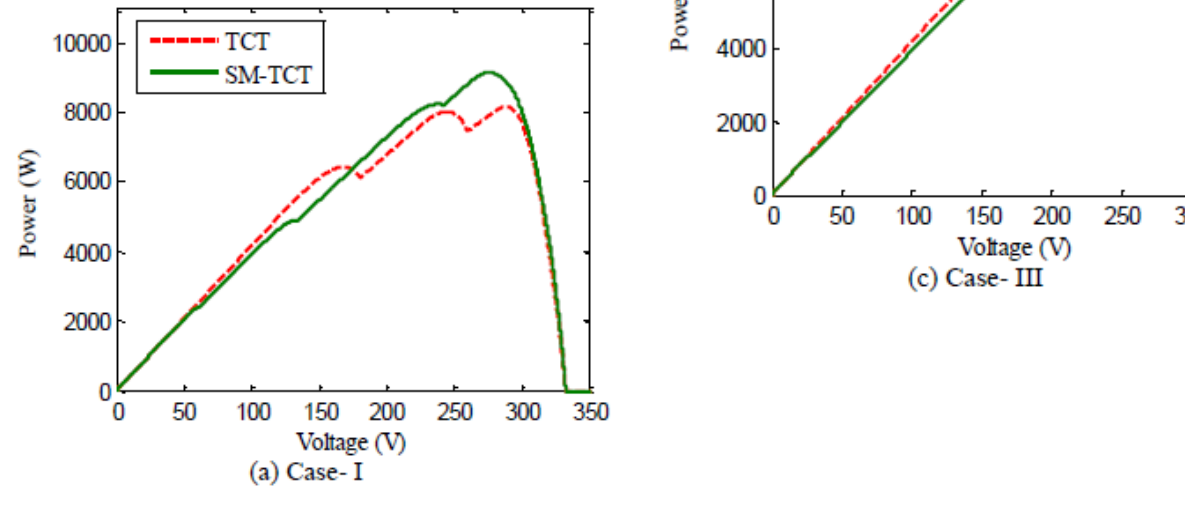
EAI Endorsed Transactions on Energy